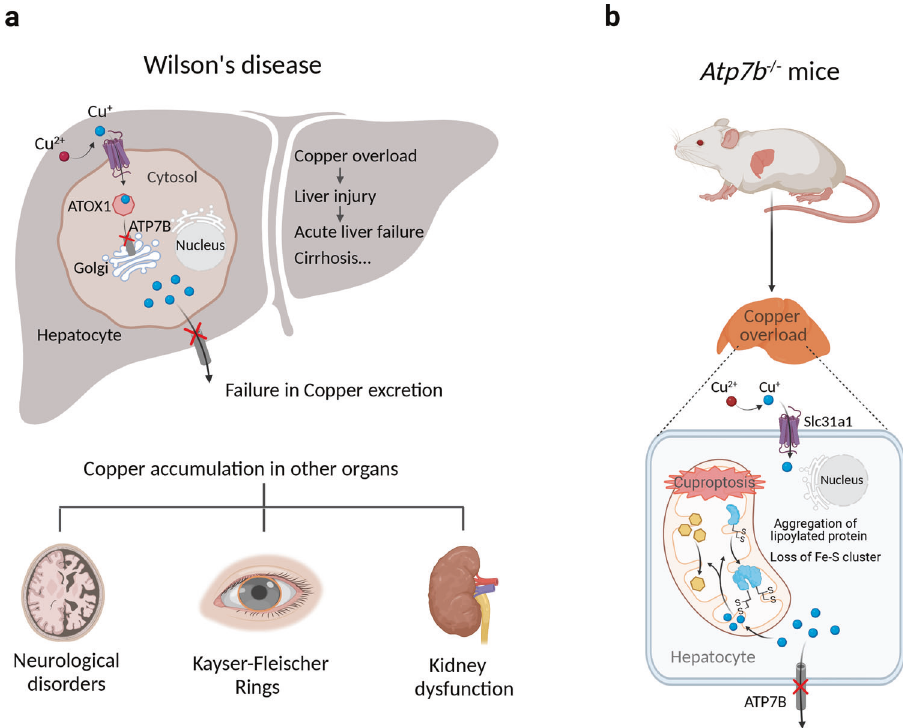
Fig. 3 The putative role of cuproptosis in Wilson ’ s disease. a Patients with Wilson ’ s disease present with Cu overload in their hepatocytes. Mutations in ATP7B impair Cu loading into secretory vesicles and into cuproproteins such as ceruloplasmin. Cu excretion via the biliary tract is also impaired, resulting in an accumulation of Cu in the liver. The resulting Cu-induced toxicity leads to chronic liver disease and cirrhosis. Cu also accumulates in other tissues, including the brain, cornea, and kidneys, resulting in neurological impairment, Kayser – Fleischer rings, and impaired kidney function, respectively. b Atp7b knockout mice (a model of Wilson ’ s disease) develop Cu overload, with a loss of lipoylated and Fe – S cluster proteins in the liver, suggesting that this Cu overload has similar cellular effects as those induced by Cu ionophores, suggesting that cuproptosis may play a pathogenic role in Wilson ’ s disease. Created with BioRender. ATOX1 antioxidant 1 copper chaperone-1, ATP7B ATPase Cu transporter 7B, Fe – S iron – sulfur, Slc3a1 solute carrier family 3 member 1, STEAP six-transmembrane epithelial antigen of